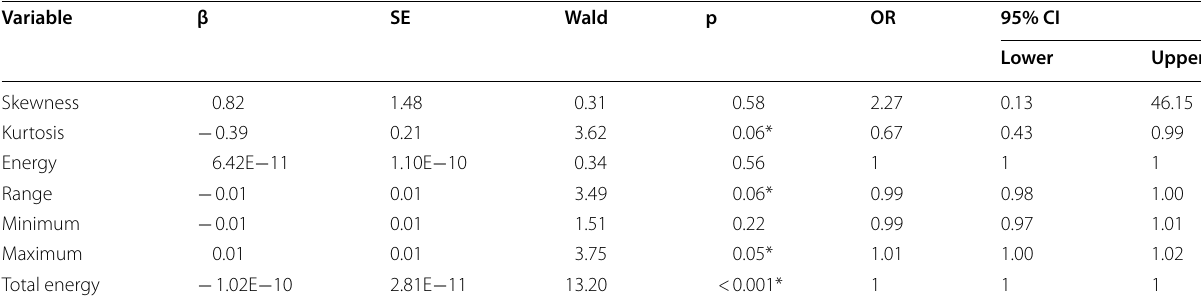
CI confidence interval, OR =